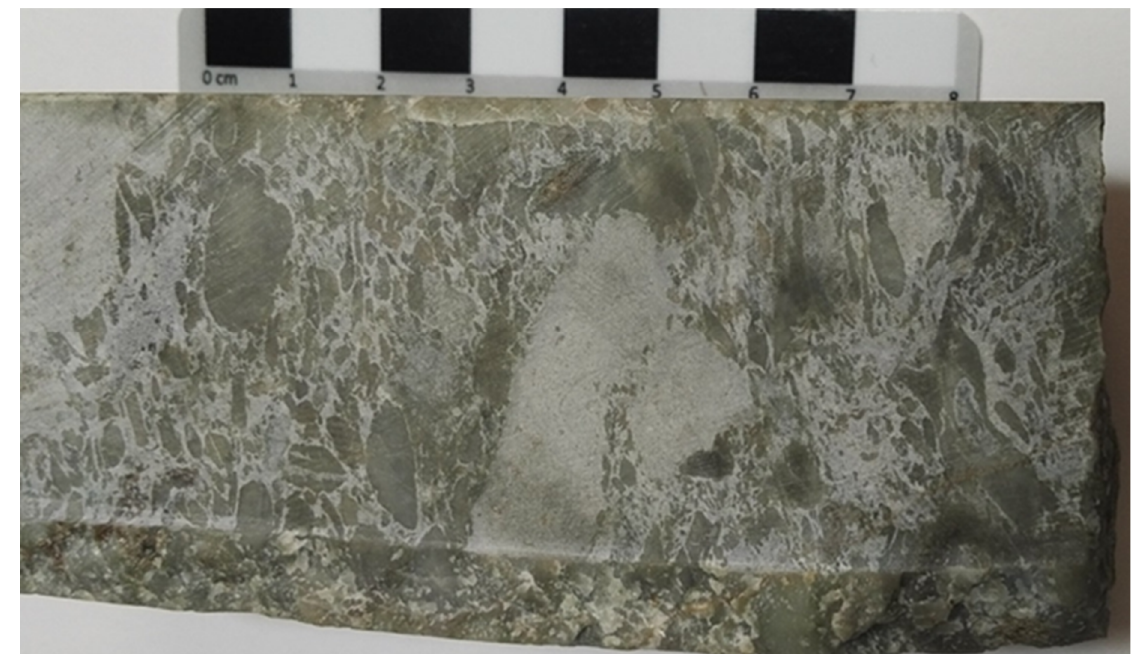
Figure 2. Photograph of core sample of Unit 3D showing greenish grey skarn phosphate clasts in a whitish grey carbonate matrix.